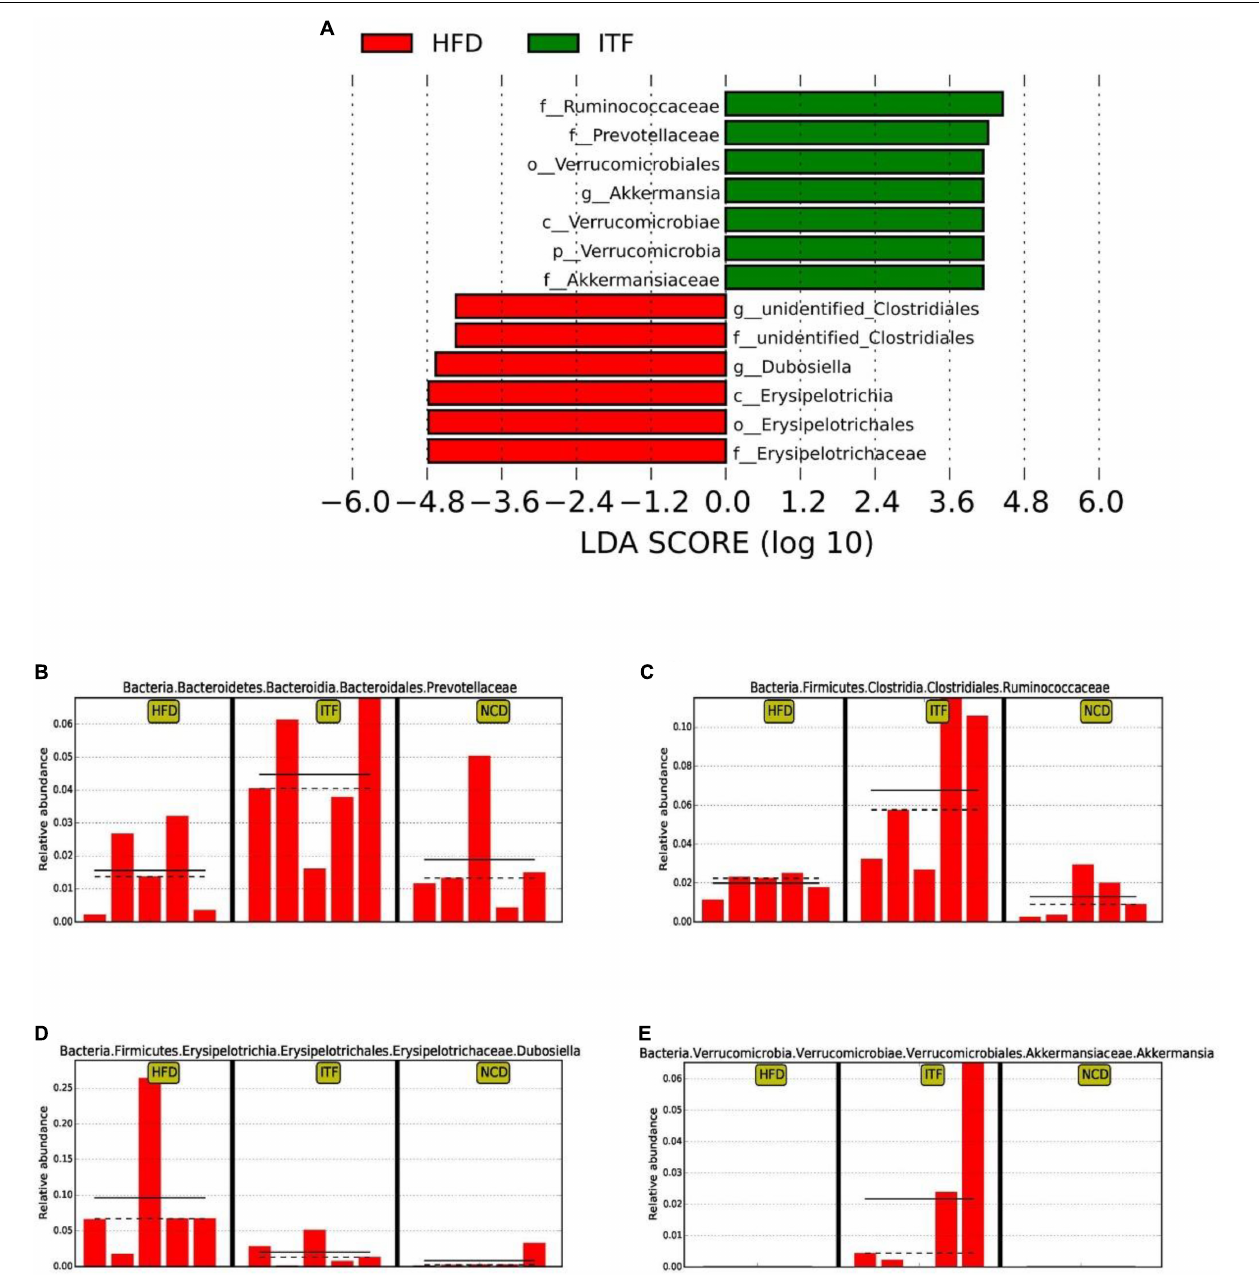
FIGURE 7 | Identification of the most differentially abundant among HFD, ITF, and NCD analyzed by the LEfSe method. (A) LDA scores of differentially abundant taxa. (B) Relative abundance of Prevotellaceae. (C) Relative abundance of Ruminococcaceae. (D) Relative abundance of Dubosiella . (E) Relative abundance of Akkermansia